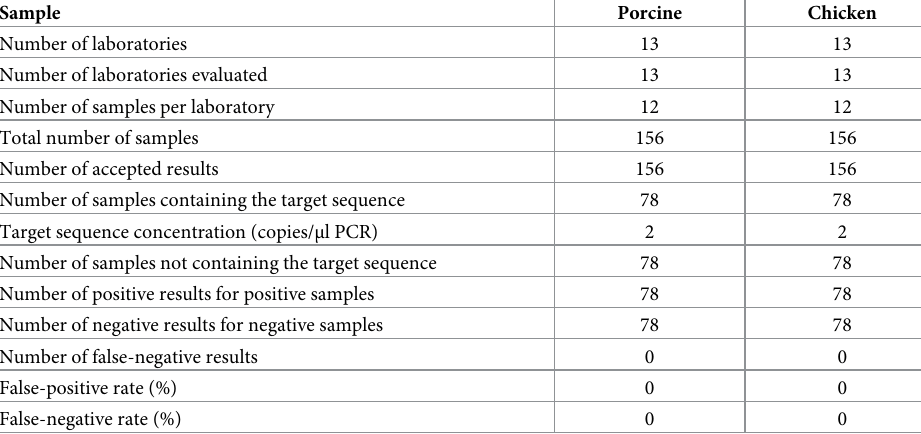
Number of positive results for positive samples Number of negative results for negative samples